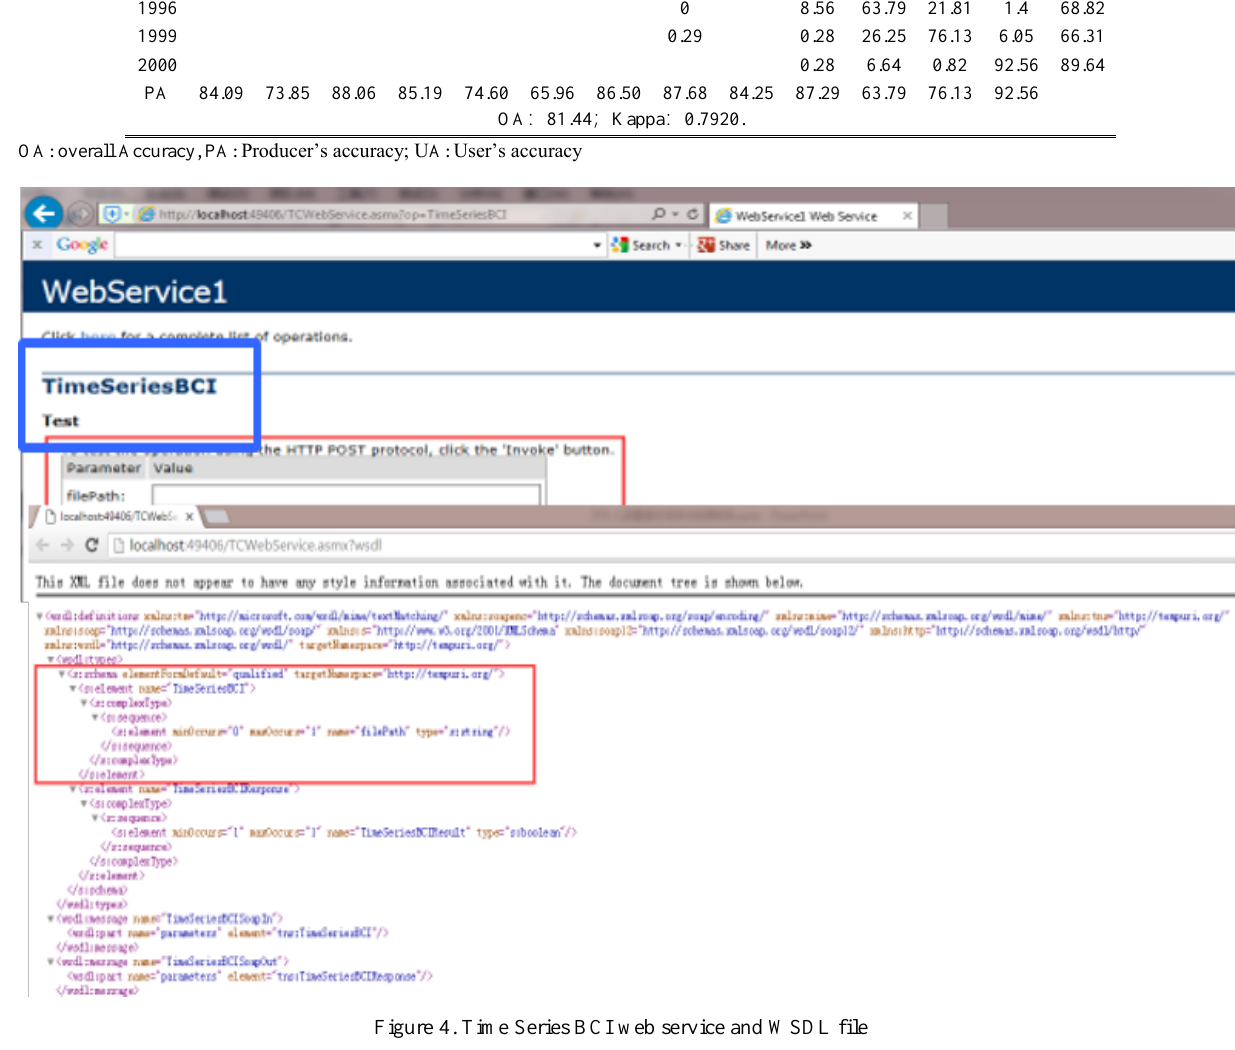
Figure 4. Time Series BCI web service and WSDL